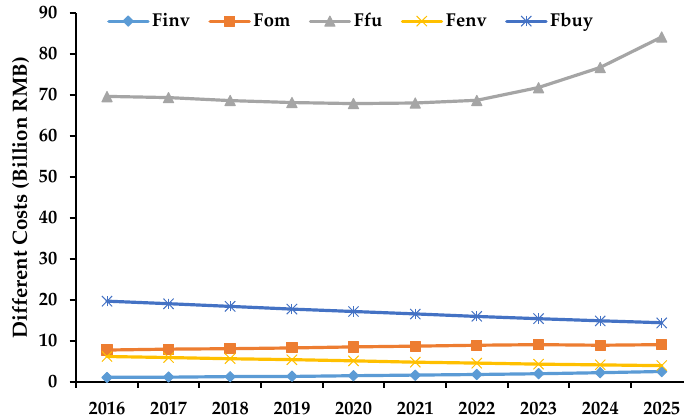
Figure 6. Changes in various costs in the planning horizon.